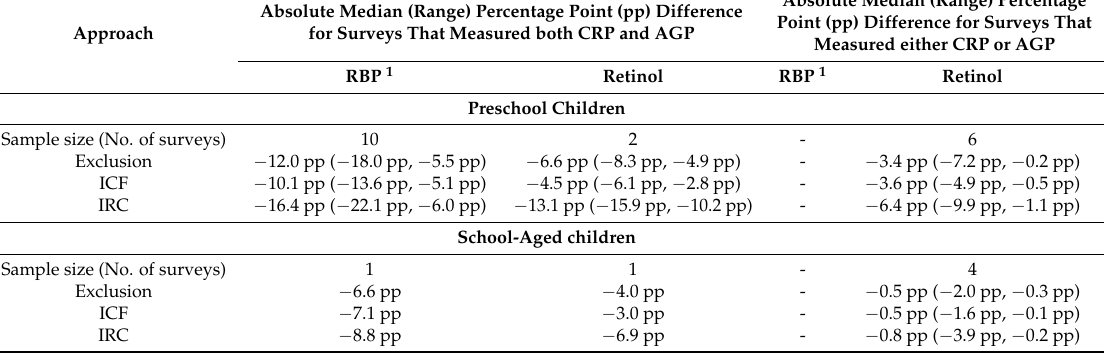
Table 2. Summary of change in estimated vitamin A deficiency (VAD) by adjustment method across surveys, preschool age children, and school age children, BRINDA project. Absolute Median (Range) Percentage Absolute Median (Range) Percentage Point (pp) Difference Point (pp) Difference for Surveys That Approach for Surveys That Measured both CRP and AGP Measured either CRP or AGP RBP 1 Retinol RBP 1 Retinol Preschool